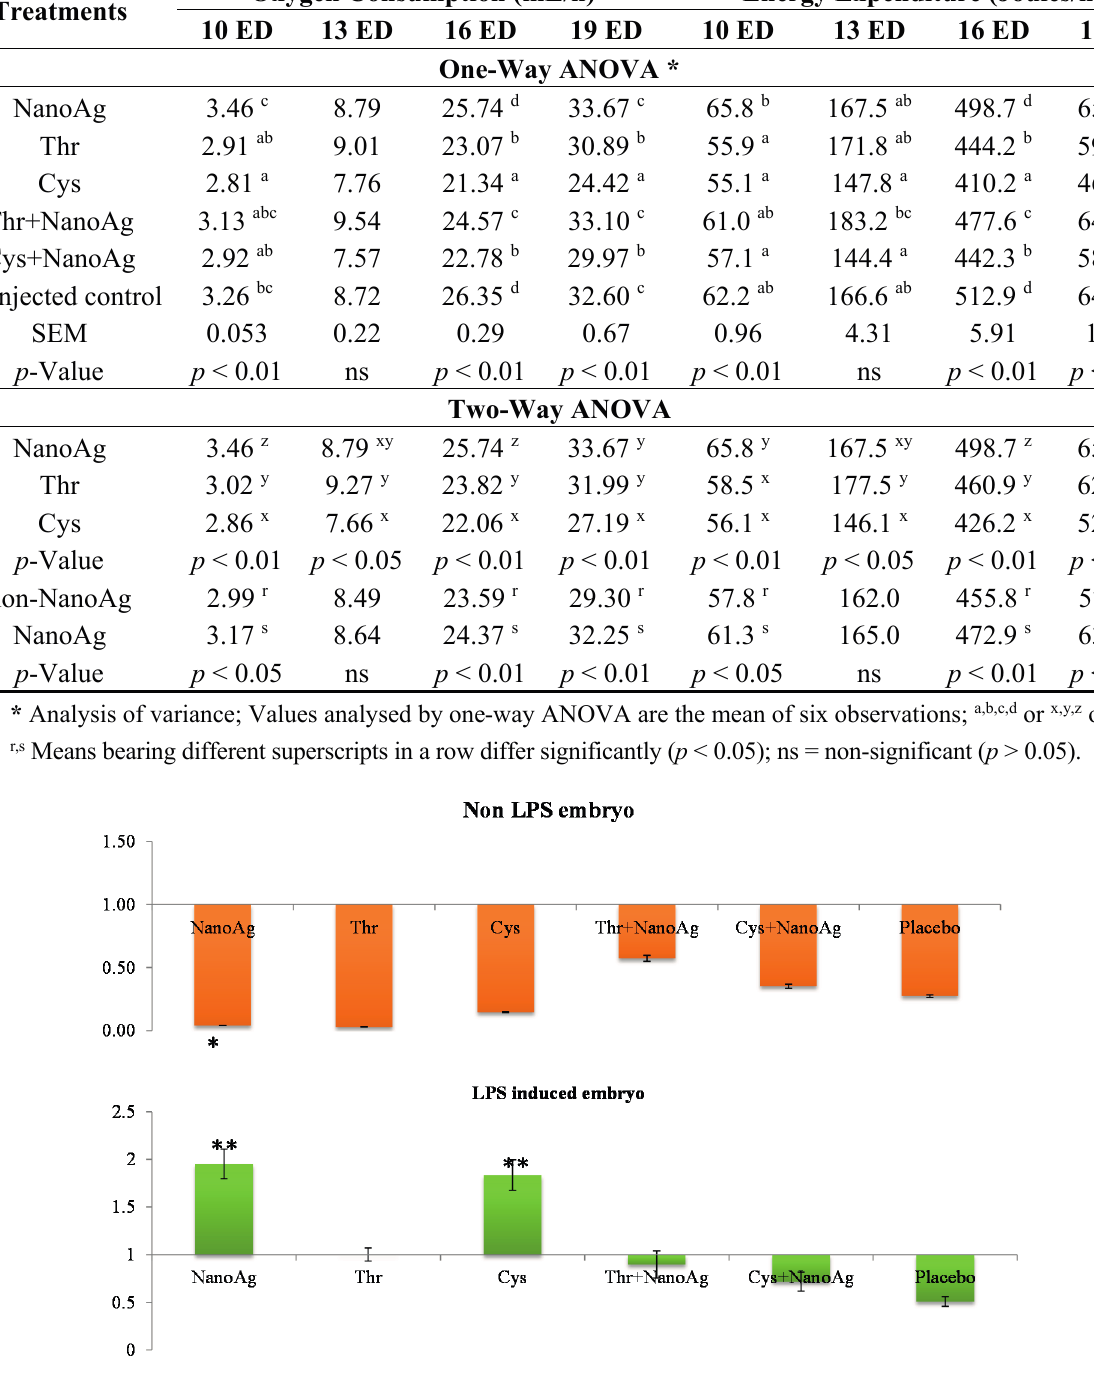
Figure 1. Relative fold expression level of insulin-like growth factor-I ( IGF-I ) gene in hepatic tissues of normal (non-LPS) and lipopolysaccharide (LPS) induced in ovo NanoAg and/or amino acid injected embryos. Expression of uninjected control embryo is taken as 1.0. * and ** indicates significant expression at the level of 95% ( p < 0.05) and 99% ( p < 0.01),